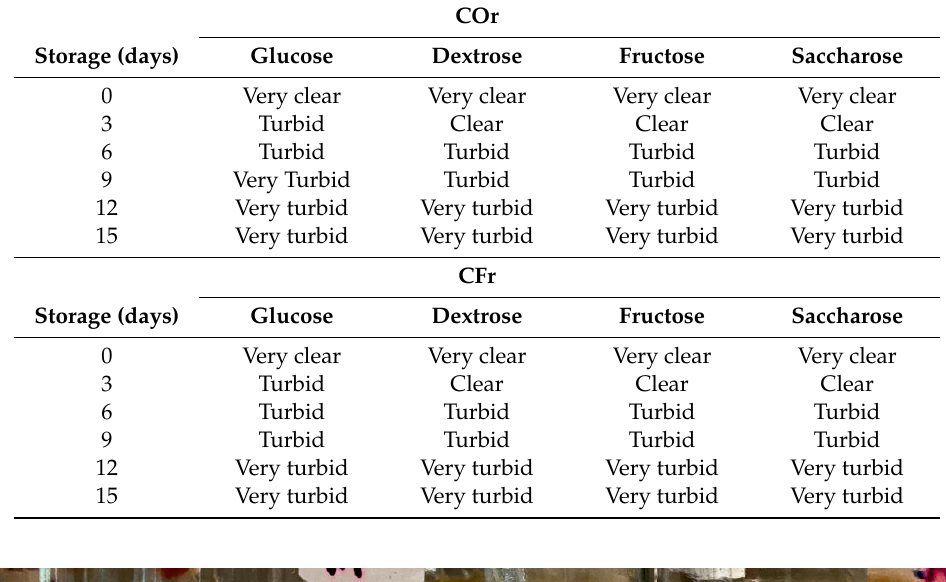
Table 3. Changes in the clarity level of kombucha fermentations with various carbon sources stored at 25 °C for 15 days.